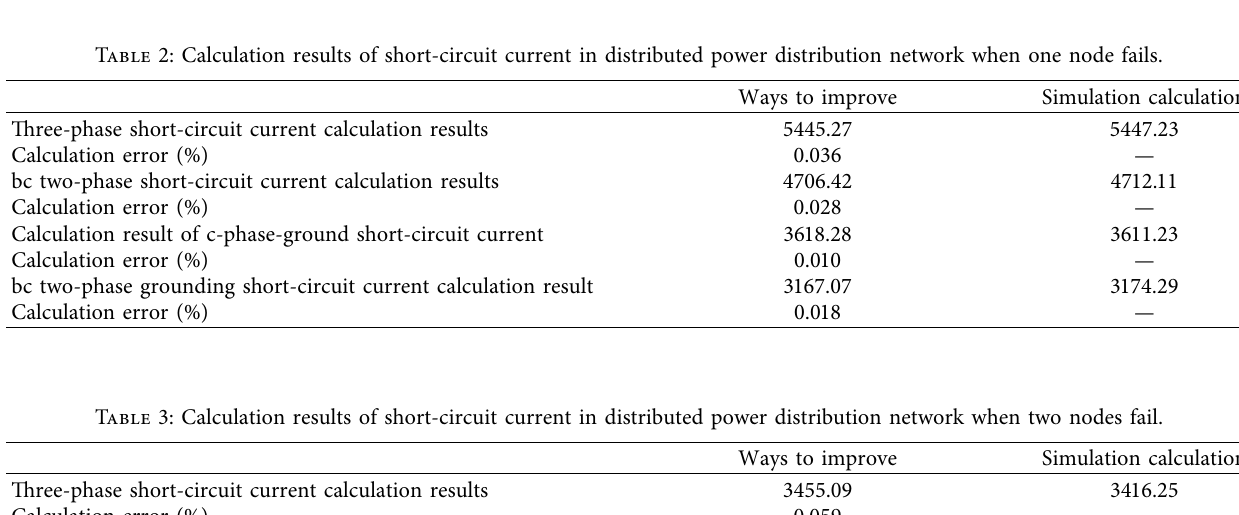
Ways to improve